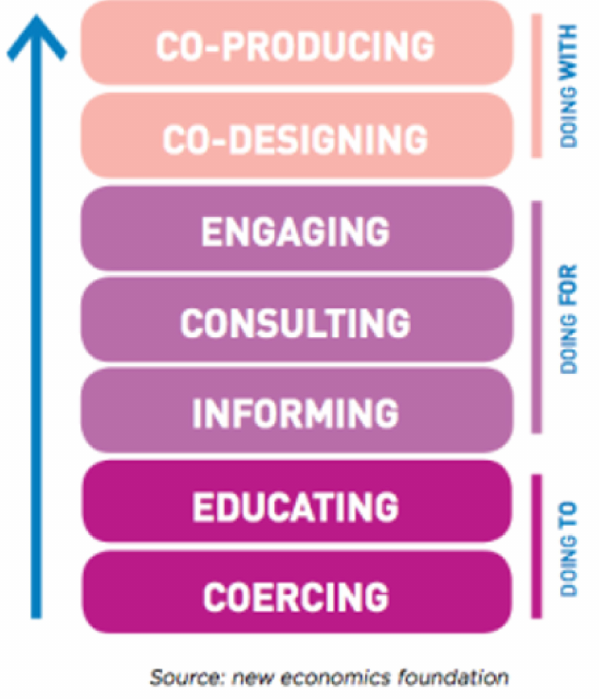
Figure 2. New Economics Foundation Ladder of Participation.